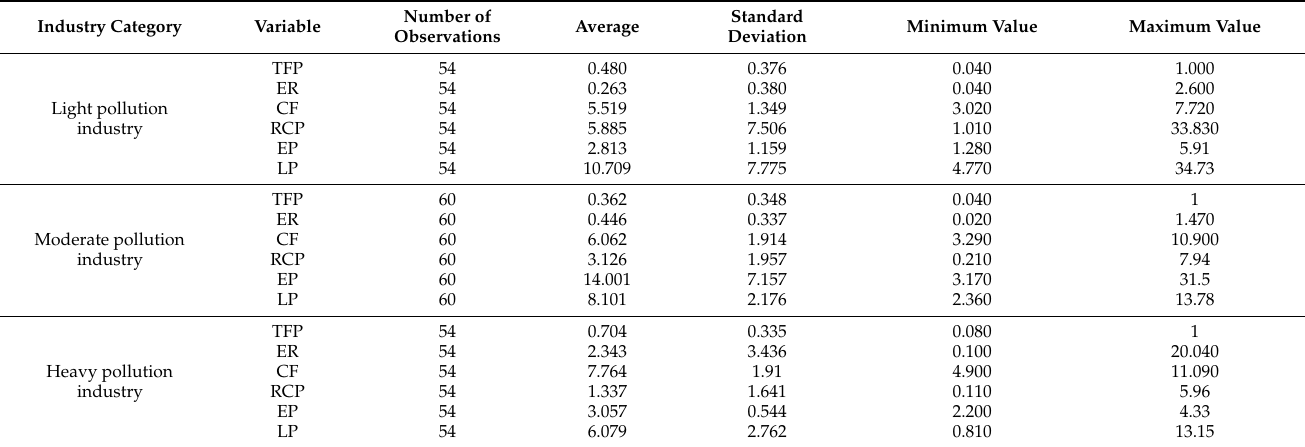
Table 6 below: Table 6. Descriptive statistics of the regression